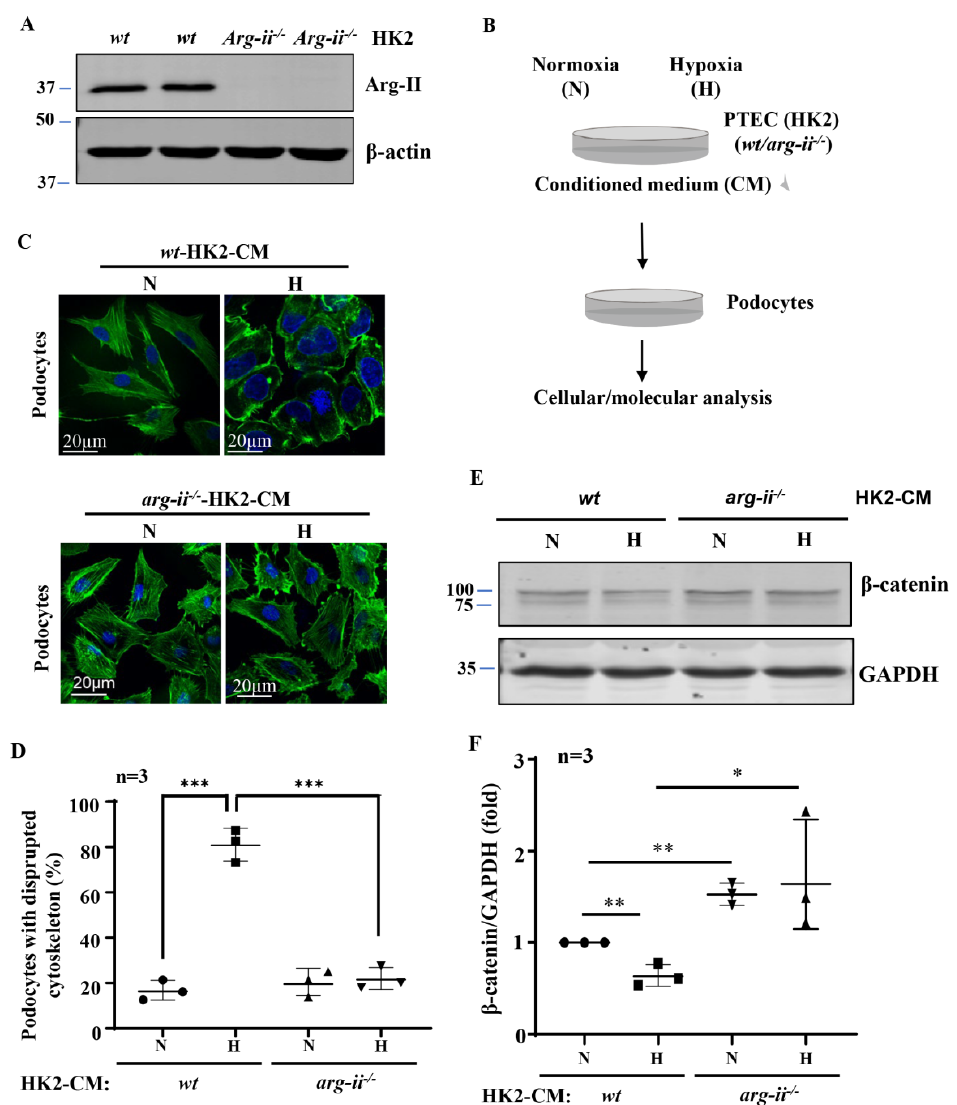
Figure 1. Arg-ii deficiency in human renal epithelial cells prevents hypoxia-induced paracrine effects of the cells on podocyte cytoskeleton derangement. ( A ) Immunoblotting revealing arg-ii deficiency in arg-ii −/− HK2 cells. ( B ) Schematic illustration of the experimental setup to study crosstalk between proximal tubular epithelial cells (PTECs) and podocytes. Human PTECs (HK2-CRISPR- wt and -CRISPR- arg-ii −/− ) were exposed to either normoxia (21% O 2 ) or hypoxia (1% O 2 ) conditions for 48 h. Conditioned medium (CM) was then collected from HK2 cells and transferred to the human differentiated podocyte (AB8/13) for 24 h of incubation. Cell lysates of AB8/13 were then prepared and subjected to downstream analysis. ( C ) Representative images showing phalloidin staining of cytoskeletal actin fibers (green) in human podocytes treated with different HK2-CM as indicated. The nucleus was stained with DAPI (blue). ( D ) The quantification of the podocytes with disrupted actin cytoskeleton (in percentage). ( E ) Immunoblotting analysis of the protein levels of β -catenin; GAPDH serves as the loading control. ( F ) Quantification of the β -catenin signals. * p < 0.05, ** p < 0.01, *** p < 0.001 between the indicated groups. n = 3; CM: conditioned media, N: normoxia, H: hypoxia.